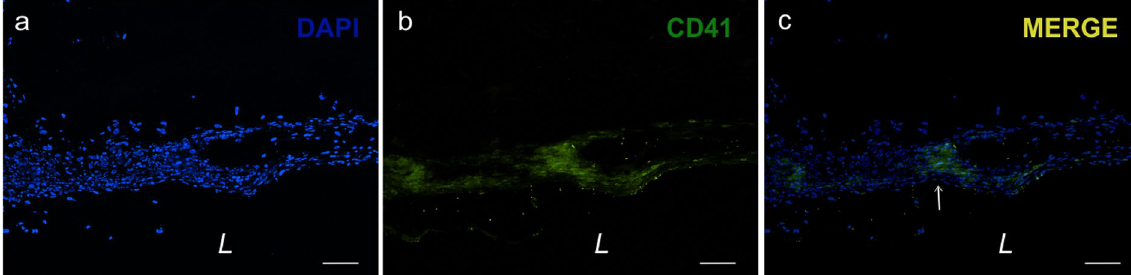
Figure 8. Very few areas of positive CD41 platelet stain indicate slight presence of adhered platelets to the adventitia rings. Inside the tissue rings, ( a ) fibroblast and platelet cell nuclei stained positive for DAPI, and ( b ) CD41 platelet stain was positive in very few 100 µ m-sized areas near the edge of the rings. ( c ) Merged image shows co-localization of DAPI and CD41 stains (white arrow) indicating presence of platelets. L = lumen. Scale bars = 100 µ